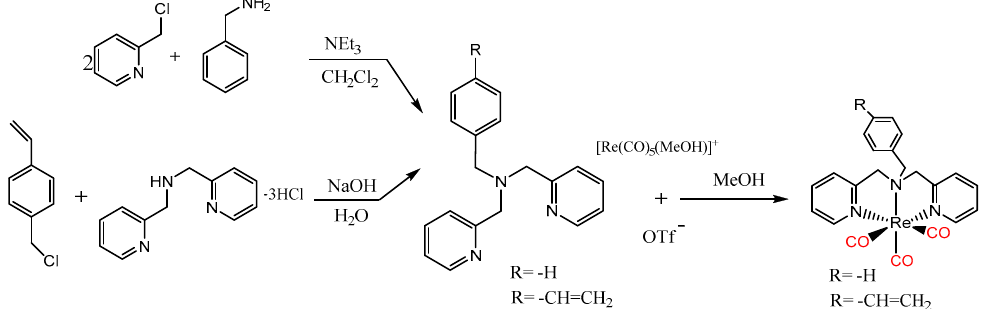
(Figure 22). HPMA ‐ copolymer